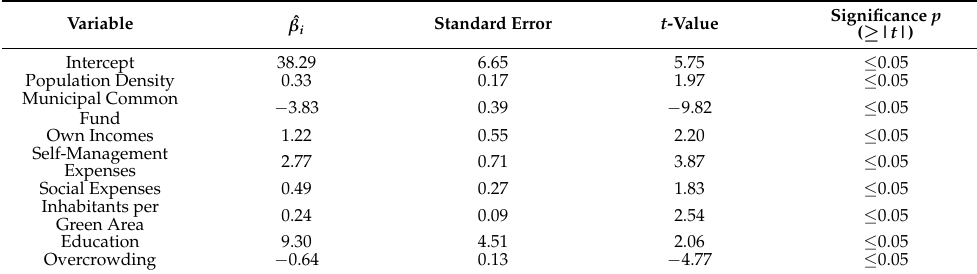
Table 9. Parameters from robust